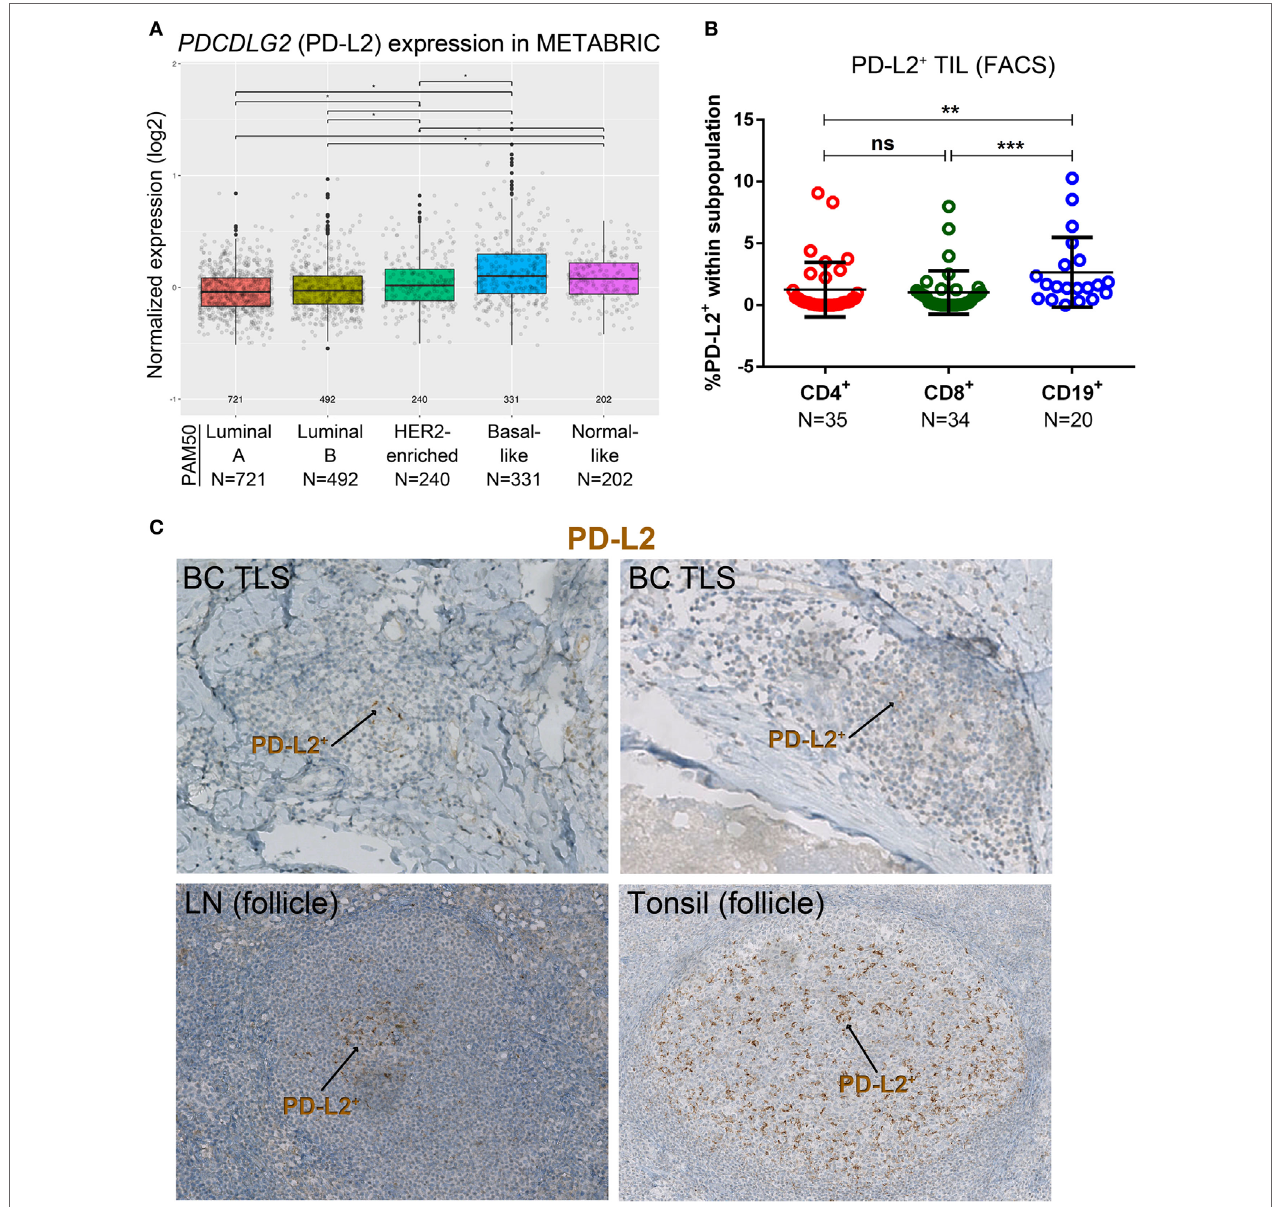
FigUre 3 | PD-L2 expression in primary breast cancer (BC). (a) Expression of the PDCDLG2 gene in BC by PAM50 molecular subtypes (microarray data from the METABRIC dataset) (37). Box plots show median ± interquartile range related to log of expression of each gene by different subypes (Luminal A, Luminal B, HER2-enriched, Basal-like, and Normal-like). (B) PD-L2 expression by the major subsets (CD4 + , CD8 + , and CD19 + ) of tumor-infiltrating lymphocytes (TIL) isolated from fresh primary breast tumors analyzed by FACS. Bars show mean ± SD. The number of samples included ( N ) is based on the tumor homogenate having a threshold minimum number of TIL for analysis. (c) Expression of PD-L2 by immunohistochemistry in BC-associated tertiary lymphoid structures (TLS), in a normal human lymph node (LN), and in a human tonsil. In brown: